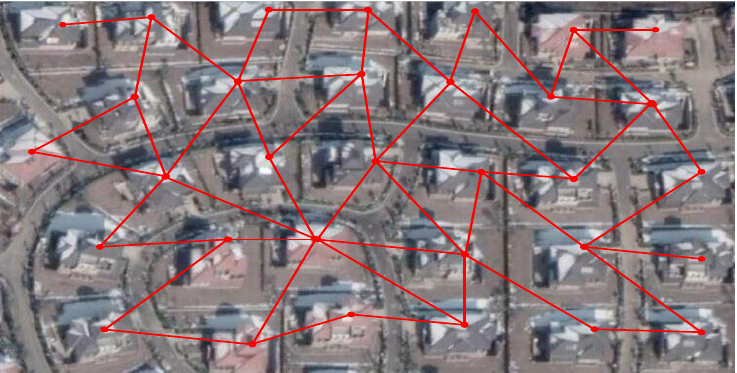
Figure 14. The IC of each customer with chain connection.